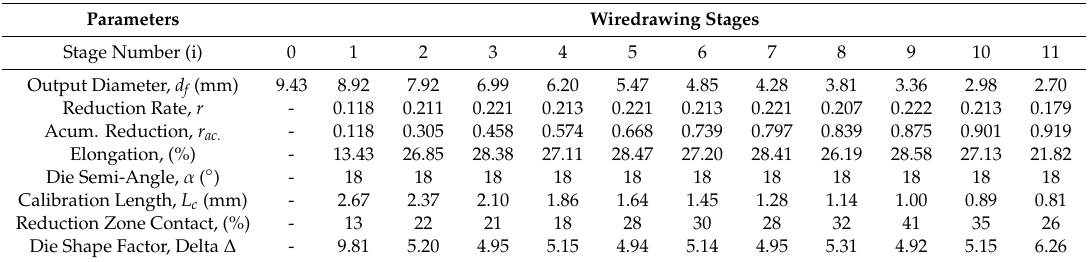
Table 3. Process setup and geometrical data for the wiredrawing of EN AW-1370 aluminium. Parameters Wiredrawing Stages Stage Number